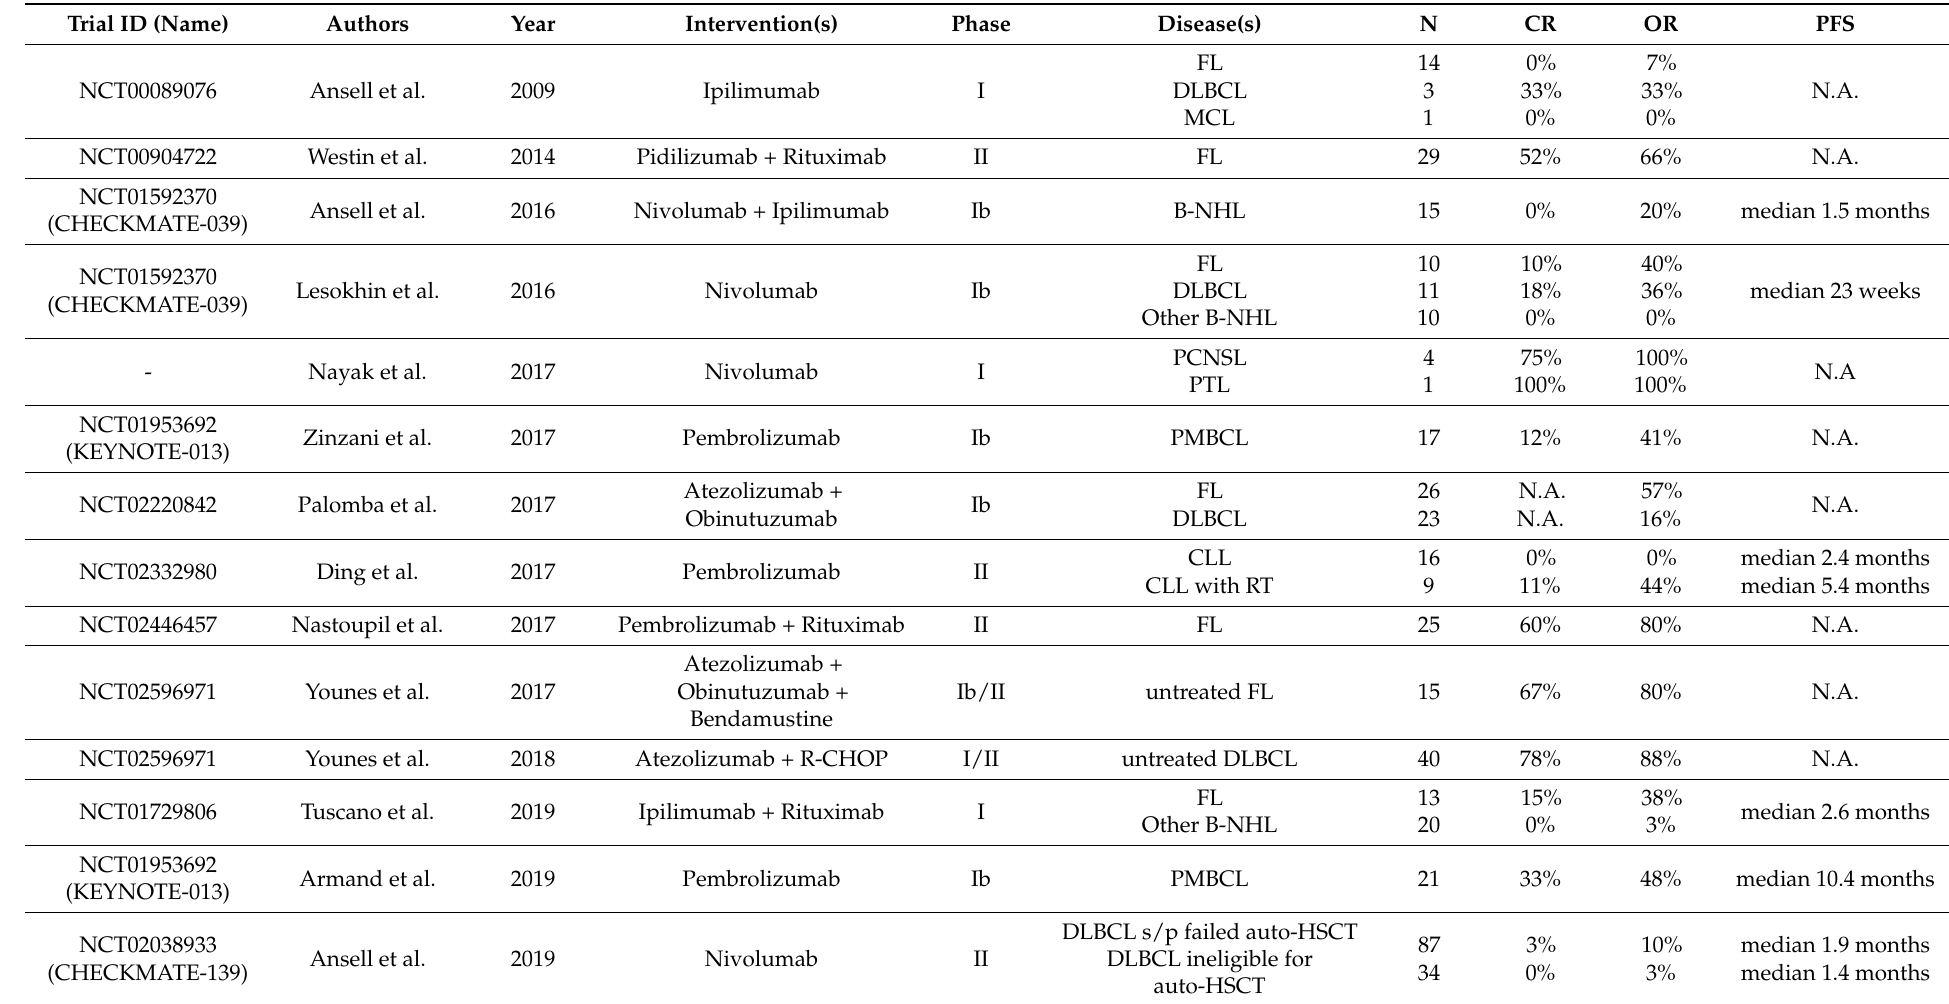
Table 1. Clinical trials of immune checkpoint inhibitors in B-cell non-Hodgkin